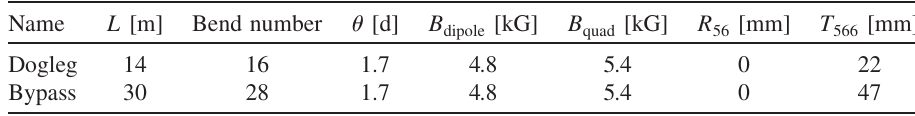
TABLE I. Beam line parameters (at a beam energy of 1 GeV).